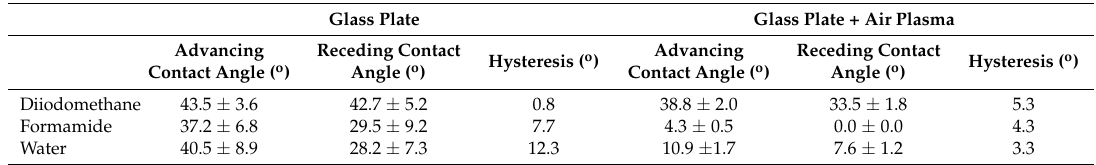
Table 1. Advancing and receding contact angles and its hysteresis of three testing liquids on the commercial glass plate before and after plasma treatment [17]. Glass